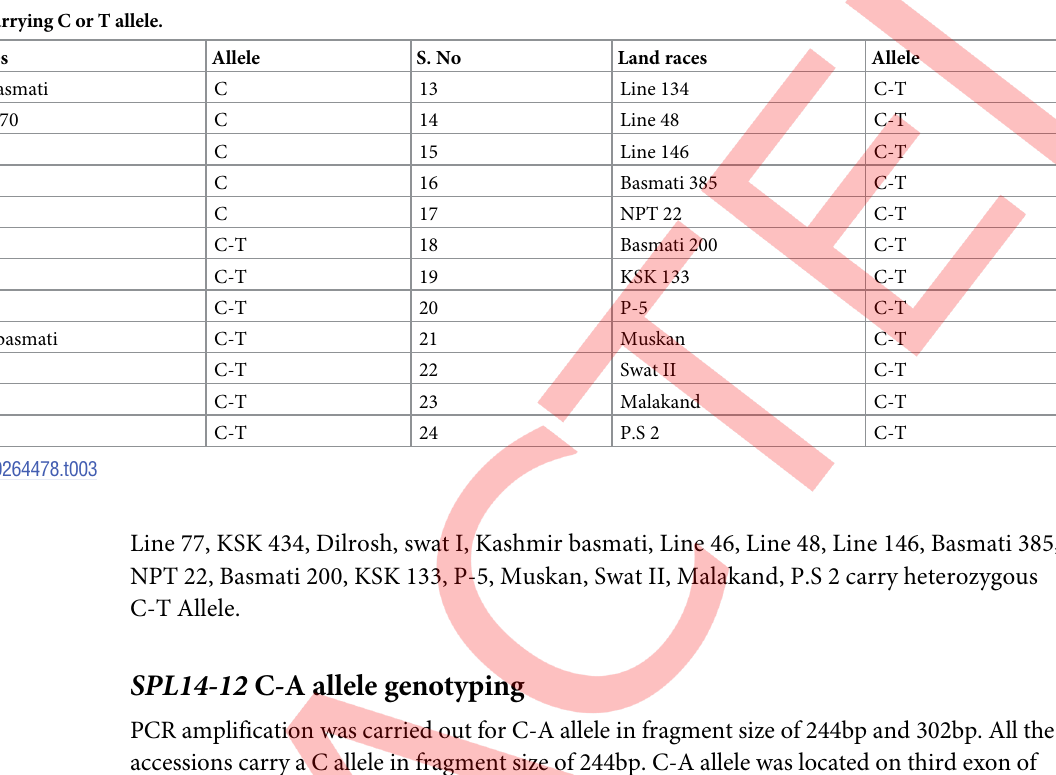
Table 3. List of rice germplasm carrying C or T allele.